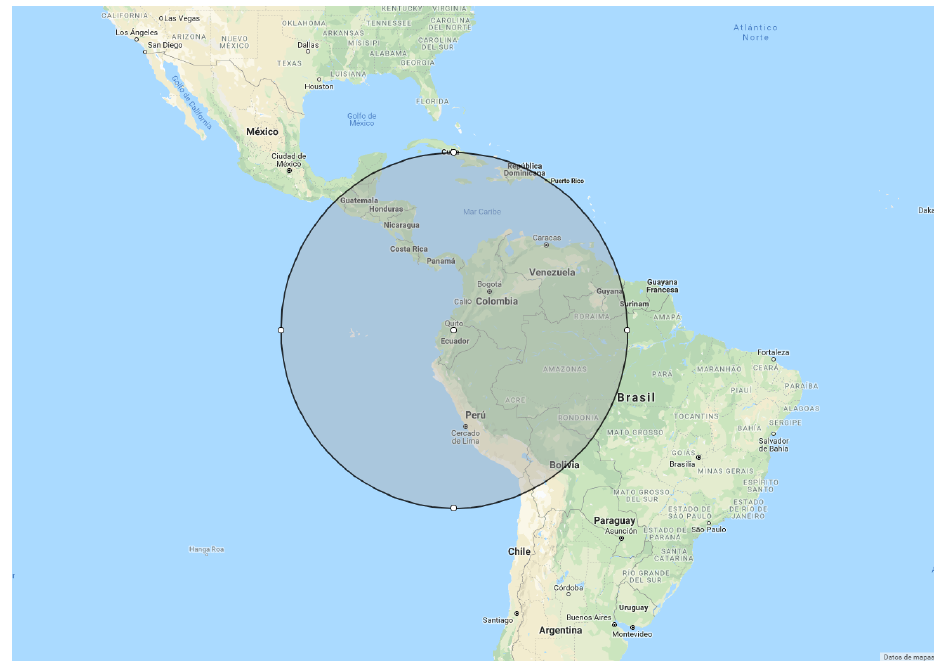
Figure 1. Geographical area from Central America where tweets were collected.